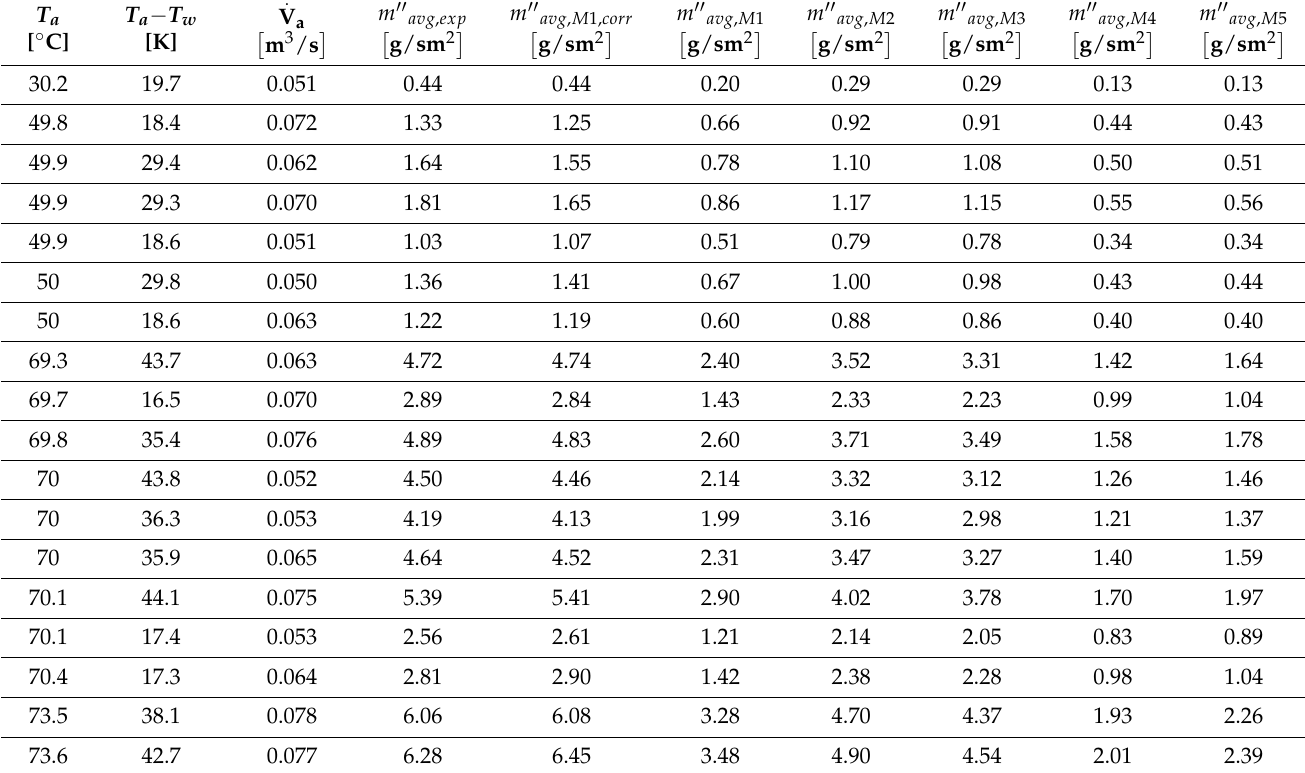
Table A1. Condensation mass fluxes obtained with our experiments, corrected M1 model, and five non-corrected (M1–M5) models and at different parameters: temperature of humid air ( T a ), temperature difference between humid air and the wall . ( T a − T w ) and volumetric flow rate of the humid air ( V a